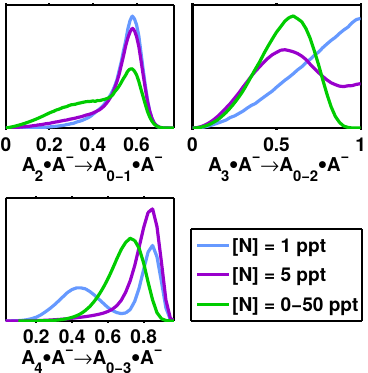
Figure 6. Posterior distributions of the total fragmentation prob- · ( H abilities of the HSO − 2 SO 4 ) 2 − 4 clusters corresponding to the 4 experimental cluster distributions and different options for treating the background ammonia concentration in the experiments where it was below the detection limit and therefore unknown. “A” stands for H 2 SO 4 and “A − ” for HSO − 4